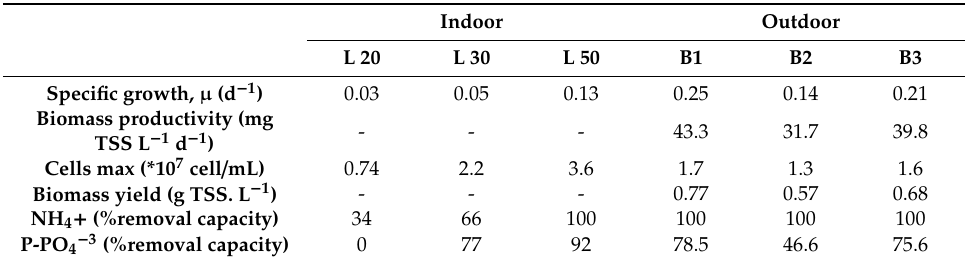
Table 2. Main microalgae performances parameters and nutrients removal e ffi ciency (%) for the culture lead in batch in indoor condition at various dilution rate of 1:20; 1:30; 1:50 and outdoor condition (B1, B2 and B3) at a dilution rate of 1:50. B1, B2 and B3 represent the three successive batches lead in outdoor condition prior to the semi-continuous